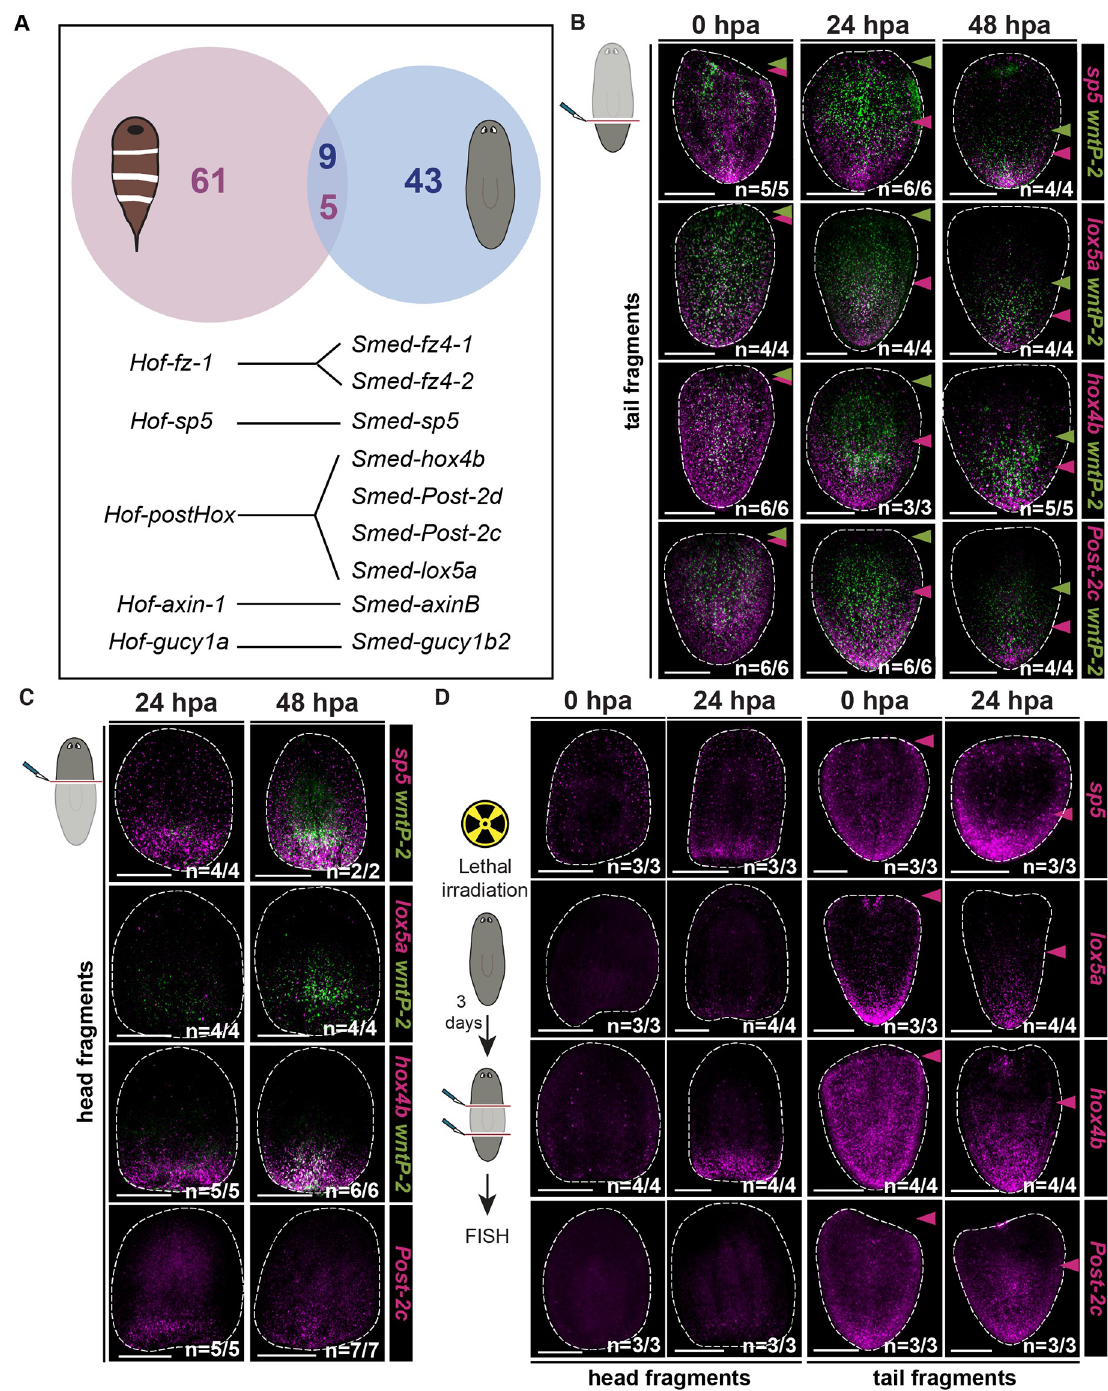
Fig 5. A small number of conserved genes are regulated by Wnt signaling in both planarians and acoels. (A) A small group of genes is down-regulated early after β -catenin-1 RNAi in planarians and acoels. Top: Venn diagram displaying overlap between Schmidtea mediterranea and Hofstenia miamia down-regulated clusters as determined by BLAST (e value < 1E-06). Bottom: List of genes obtained from BLAST overlap analysis. (B) Expression of planarian sp5 and Hox genes re-scales prior to wntP-2 re-scaling in regenerating tail fragments. FISH for sp5 , lox5a , hox4b , Post-2c (magenta), and wntP-2 (green) at 0, 24, and 48 hours post amputation in regenerating tails. (C) Planarian sp5 and Hox genes are expressed by 24 hours at posterior-facing wounds. FISH for sp5 , lox5a , hox4b , Post-2c (magenta), and wntP-2 (green) at 24 and 48 hours post amputation in regenerating heads. (D) Changes in the expression domains of planarian sp5 and Hox genes during regeneration are irradiation insensitive. FISH for sp5 , lox5a , hox4b , and Post-2c (magenta) after lethal irradiation in regenerating heads (left) and tails (right) at 0 and 24 hours post amputation. Scale bars, 200 μ m.